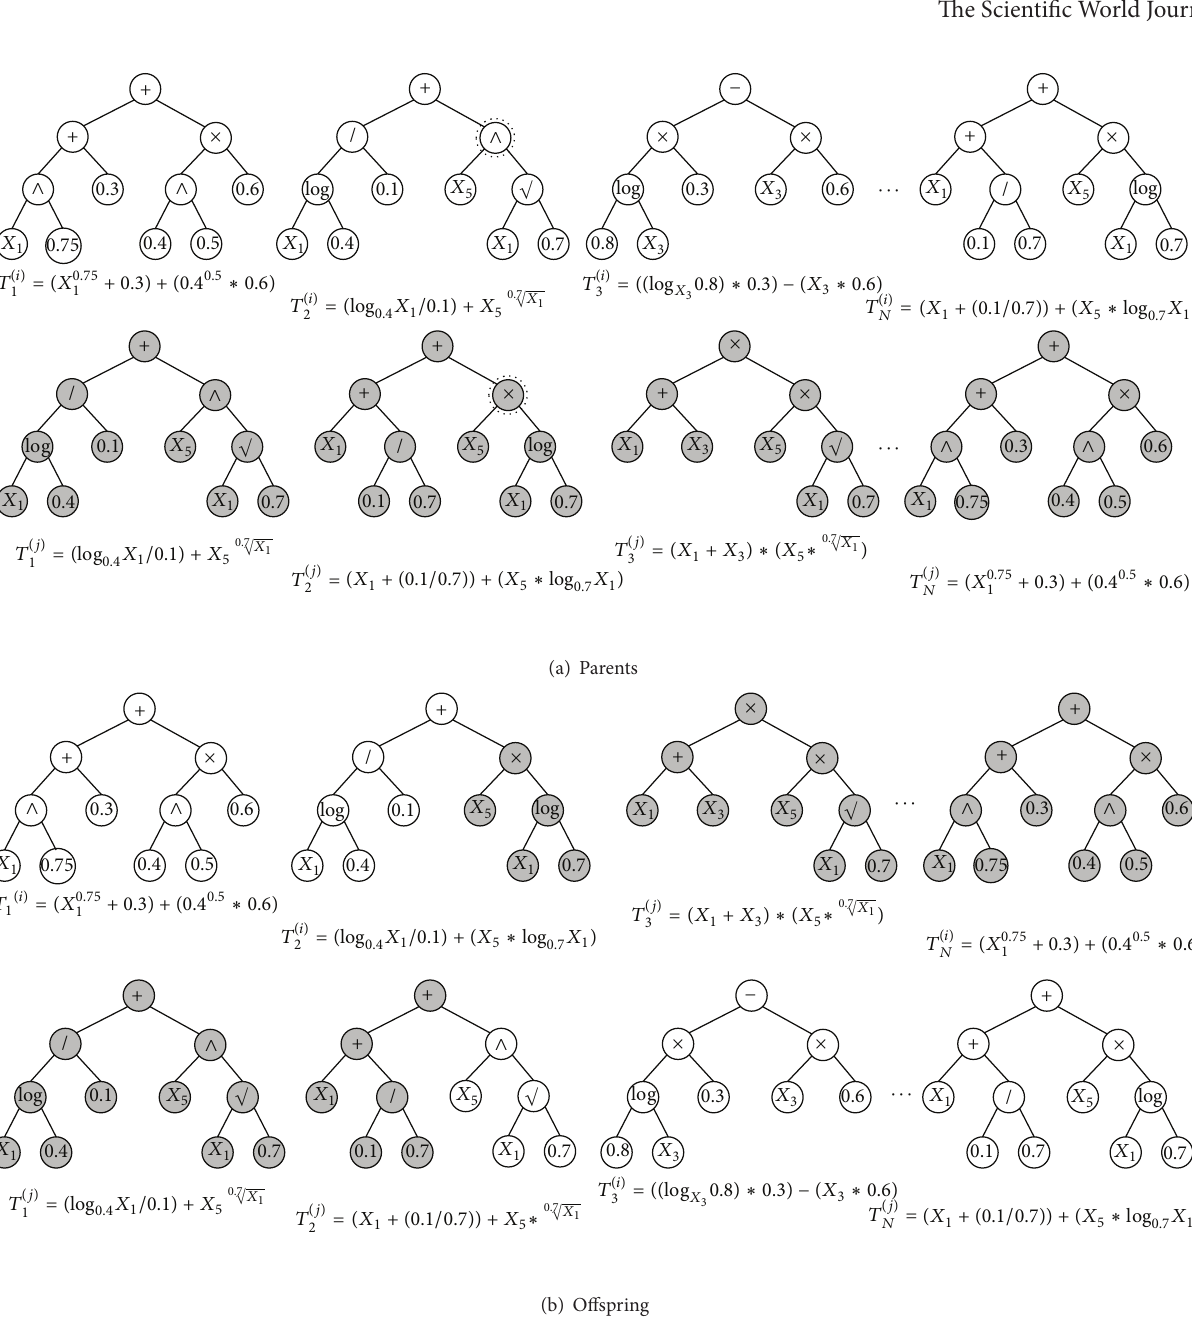
Figure 8: An example of the proposed GP